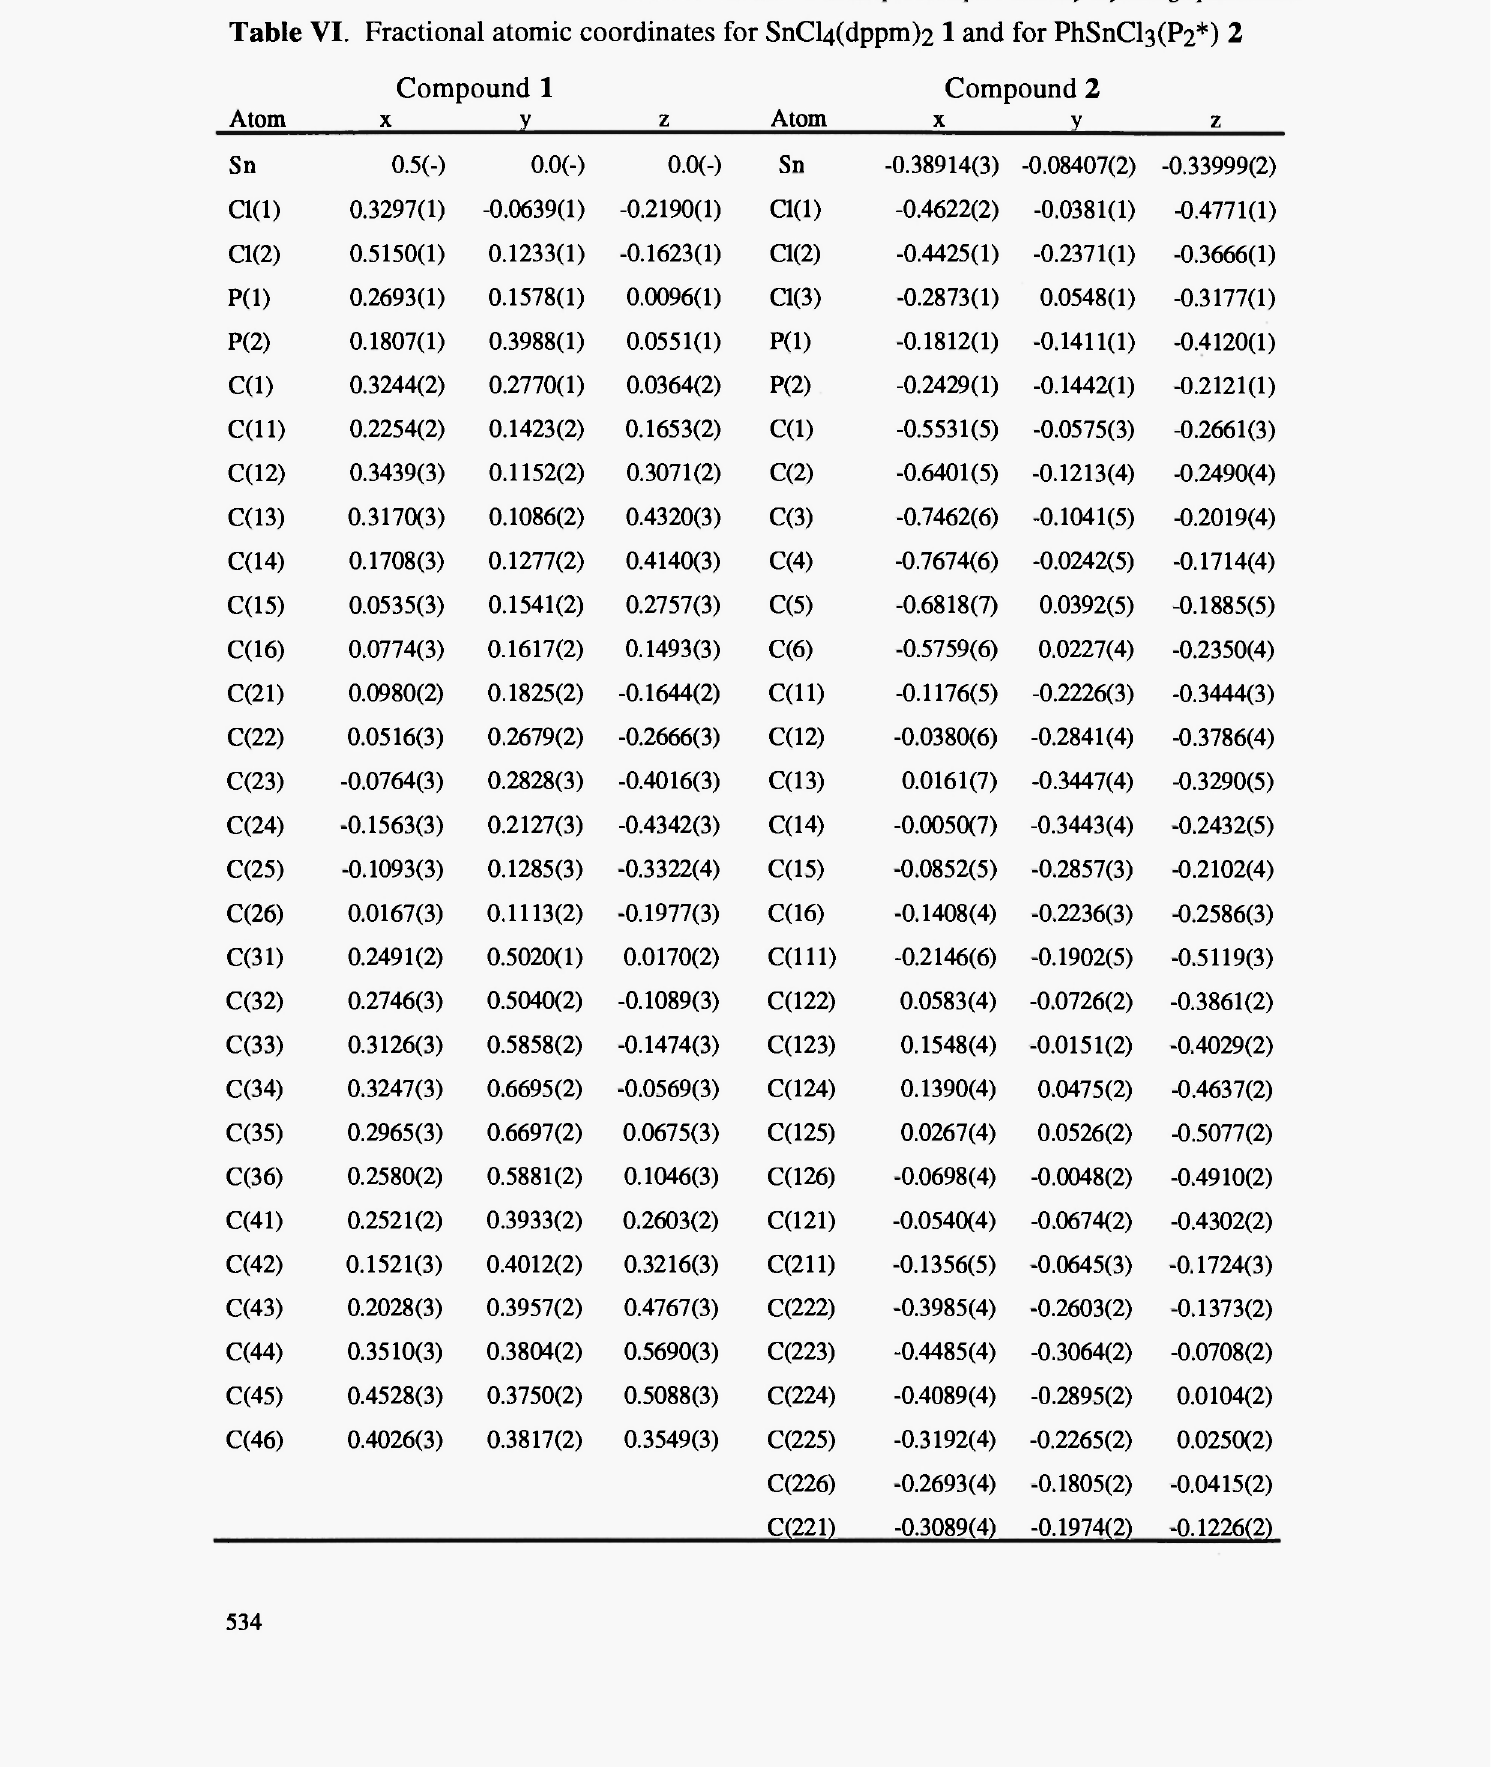
Table VI. Fractional atomic coordinates for SnCl4(dppm>2 1 and for PhSnCl3(P2*) 2 Compound